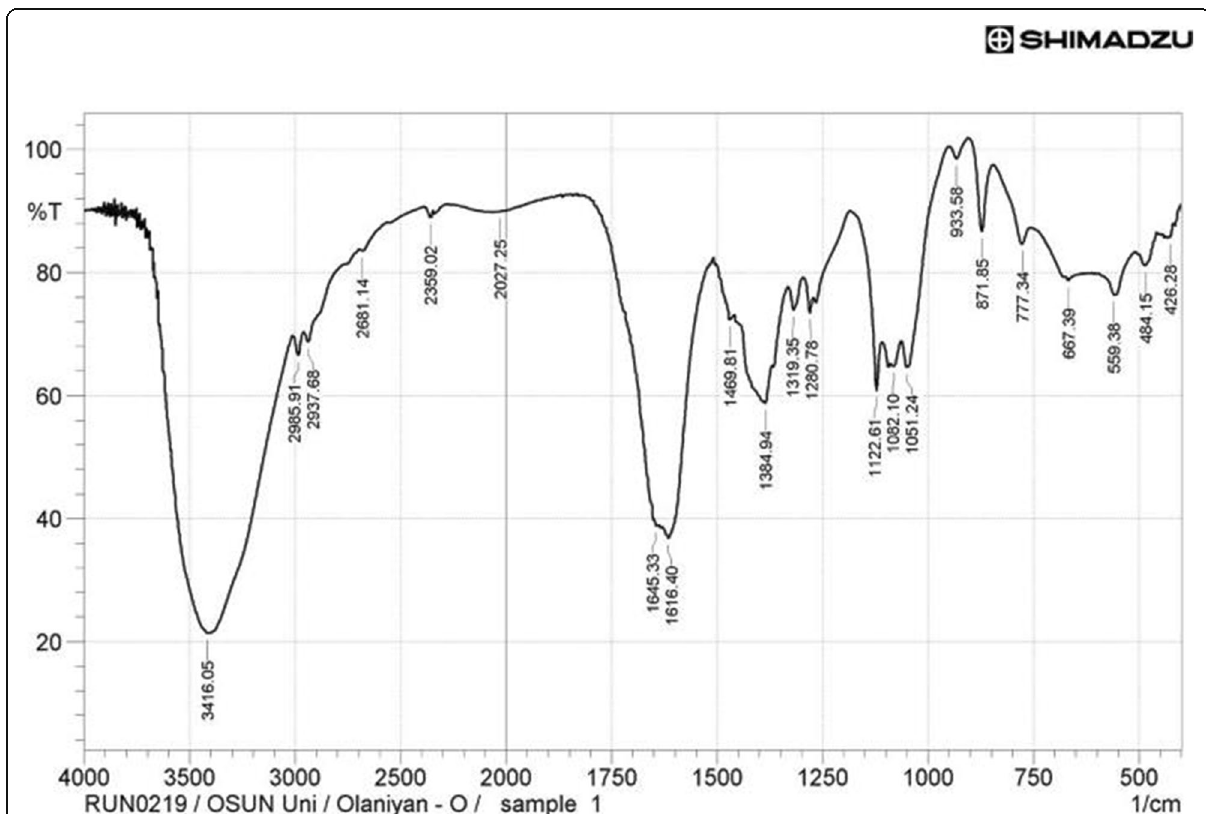
Fig. 1 Characterization of crude ethanol extract of Cassava biogas slurry (CPE) to elucidate the chemical groups present in the bioactive compounds using